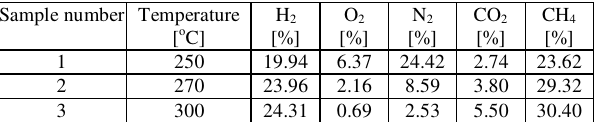
Table 5. Composition of synthesis gas obtained from glycerol at a concen- tration of 99.5%